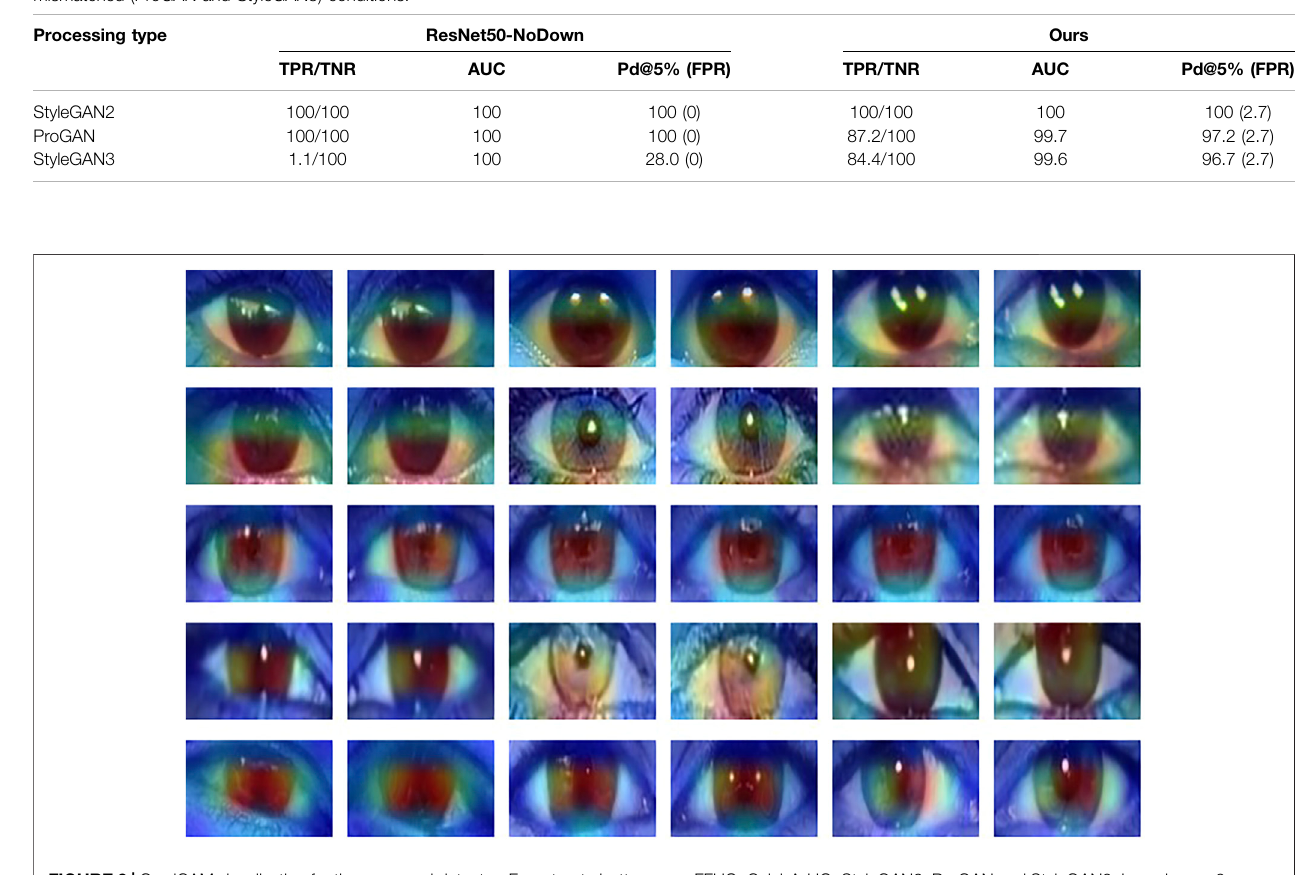
FIGURE 3 | GradCAM visualization for the proposed detector. From top to bottom row: FFHQ, CelebA-HQ, StyleGAN2, ProGAN and StyleGAN3. In each row, 3 sample pairs are visualized (left and right eyes).